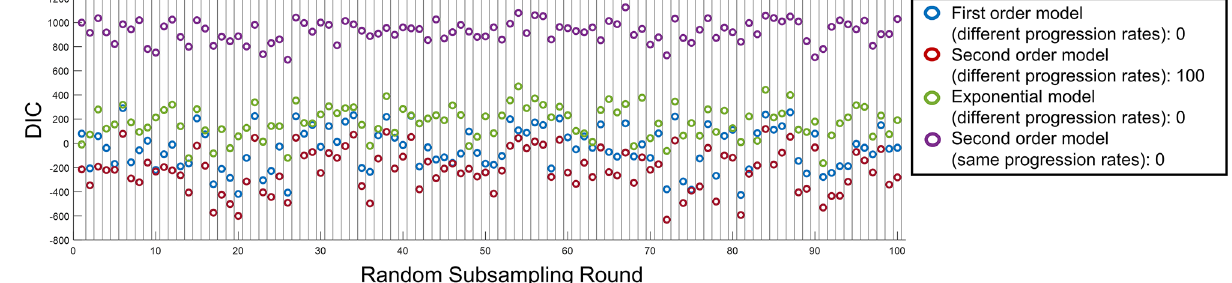
Figure 3. Comparing disease progression models based on the Bayesian entry time realignment (BETR) method in 100 random subsampling of 159 eyes with geographic atrophy (GA). The model with “different progression rates” means that the model assumes different progression rates among different patients and the model with “same progression rates” means that the model assumes the same progression rates among all patients. The number after the name of a model indicates the number of rounds when this model had the lowest DIC among all competing models. This figure suggests that BETR was able to identify the correct disease progression model in a real-world